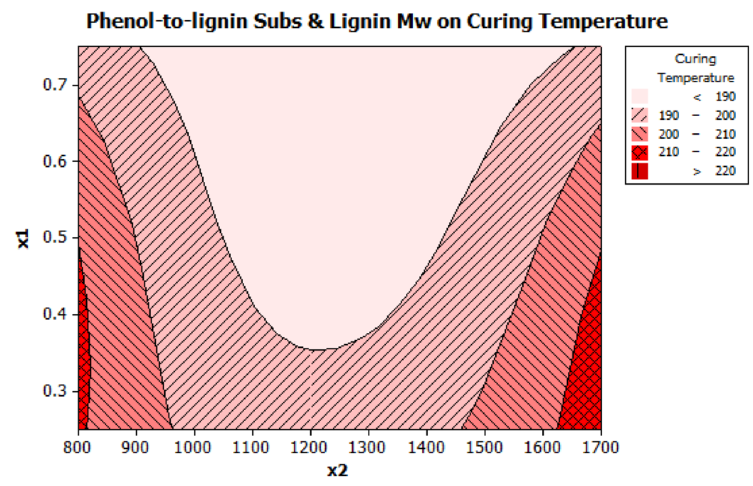
Figure 14. Contour plot for substitution of phenol with lignin (X 1 ) M w on curing temperatures of BPF resoles.